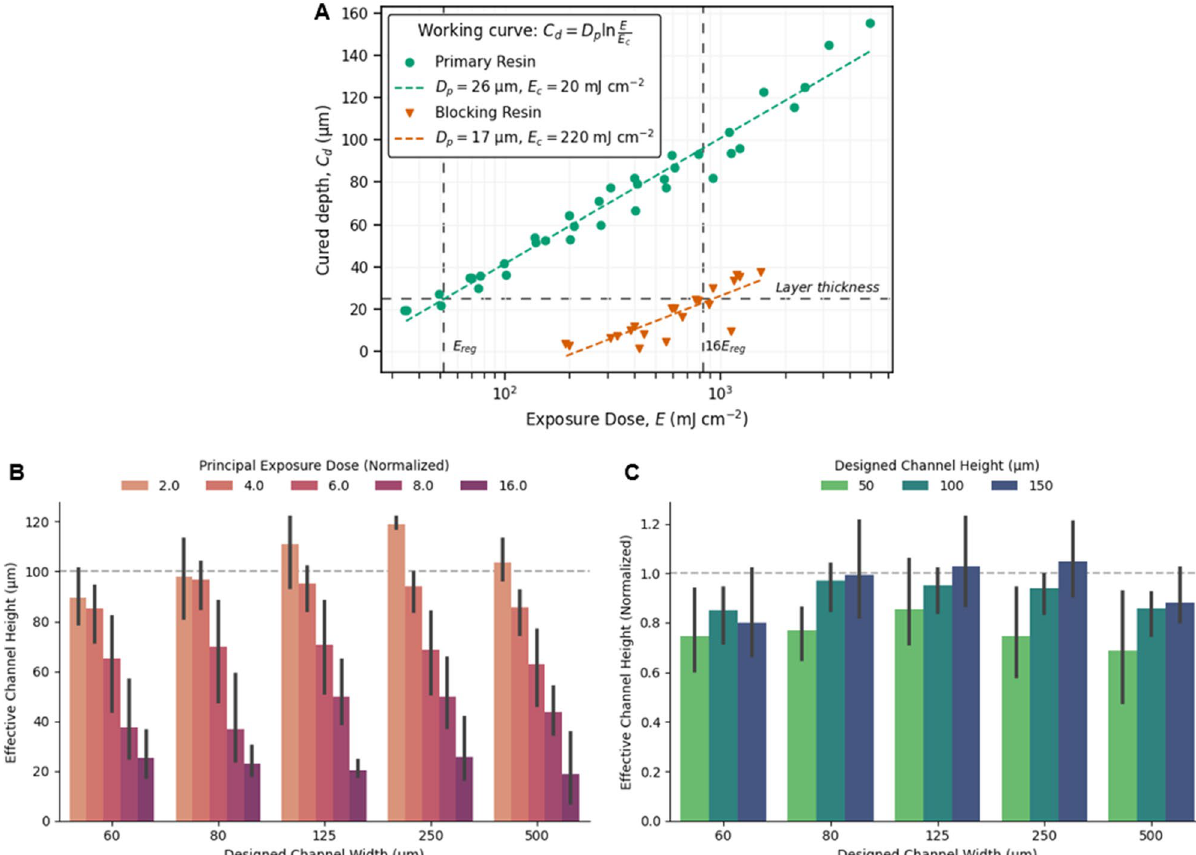
Figure 4. Characterization of the resin, blocking liquid and principal exposure dose, and their effects on print- through. ( A ) Photopolymerization characteristics of the resin (Primary Resin) and the blocking liquid (Blocking Resin) used for the results shown in ( B ) and ( C ). This plot shows the maximum polymerization thickness (cured depth, C d ) that is expected for a given incident exposure dose, E . The trendline is fitted to the fundamental “working curve” equation of stereolithography 26 , where D p is the characteristic penetration depth of light and E c is the critical energy dose required for the onset of polymerization. The dashed horizontal line at 25 μm is the layer thickness and the dashed vertical line at E reg is the exposure dose of the regular layers for the results shown in ( B ) and ( C ). ( B ) The effect of principal exposure dose on the effective channel height, where the exposure dose is normalized to E reg . ( C ) Fidelity and comparison of fabricated channels with varying designed height, where the principal exposure dose used was 4.0 E reg . In ( B ) and ( C ) the horizontal dashed lines represent the designed channel height, and the error bars represent standard deviation of process repeatability for n = 3